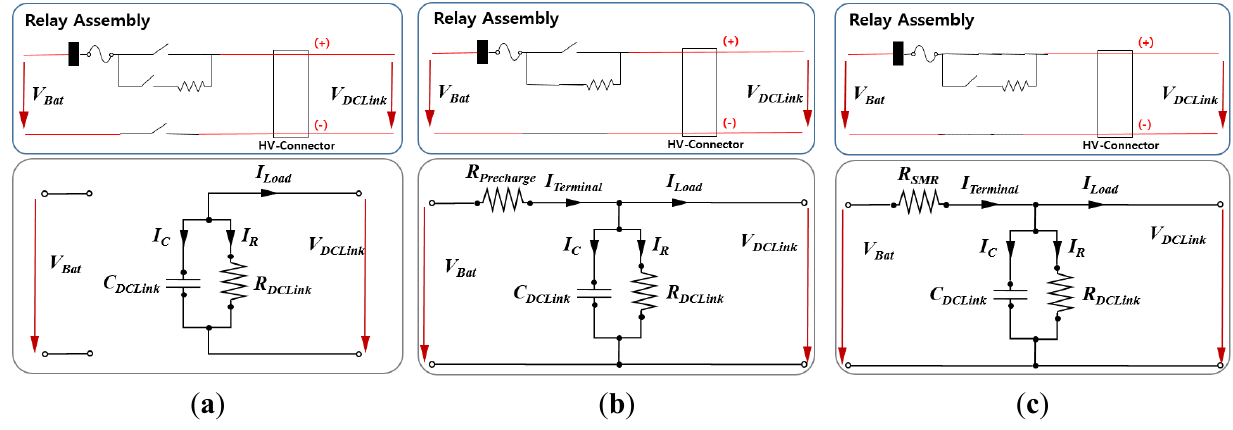
Figure 6. Equivalent circuits of relay assembly model. ( a ) Relay open; ( b ) Pre-charging; ( c ) Relay close.